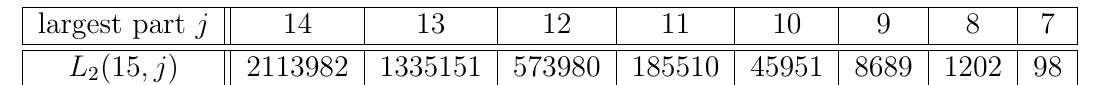
Table 5: Number L (15 , j ) of forcibly biconnected graphical degree sequences of length 15 2 with given largest term j .